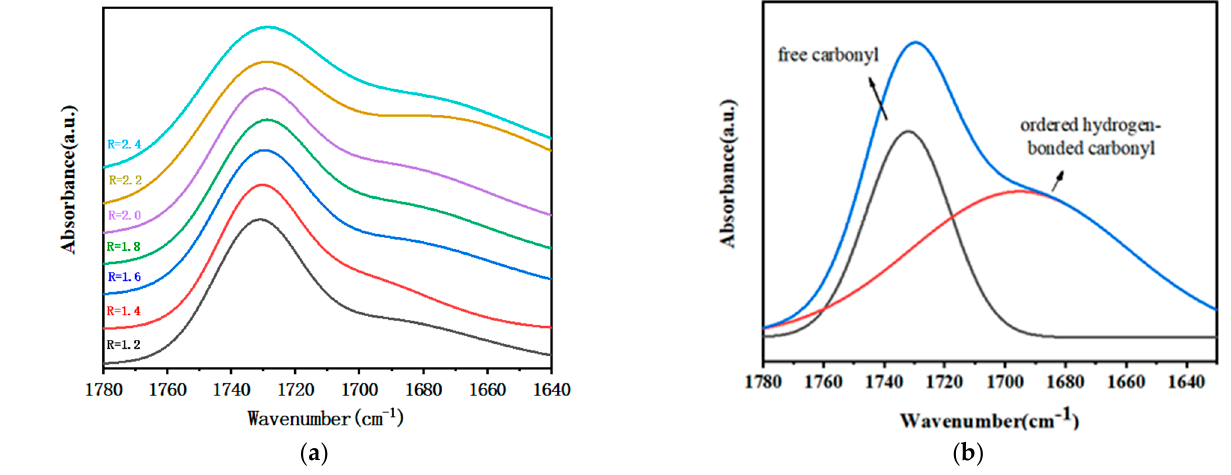
Figure 3. ( a ) FT − IR spectrum of carbonyl group of polymer fi lms with di ff erent R; ( b ) FT − IR peak Figure 3. ( a ) FT-IR spectrum of carbonyl group of polymer films with different R; ( b ) FT-IR peak fi tt ing spectrum of carbonyl group of polymer fi lms. fitting spectrum of carbonyl group of polymer films. Table 2. The bonded carbonyl ratio of GAP/TDI/GLY polymer fi lms with di ff erent R. Table 2. The bonded carbonyl ratio of GAP/TDI/GLY polymer films with different